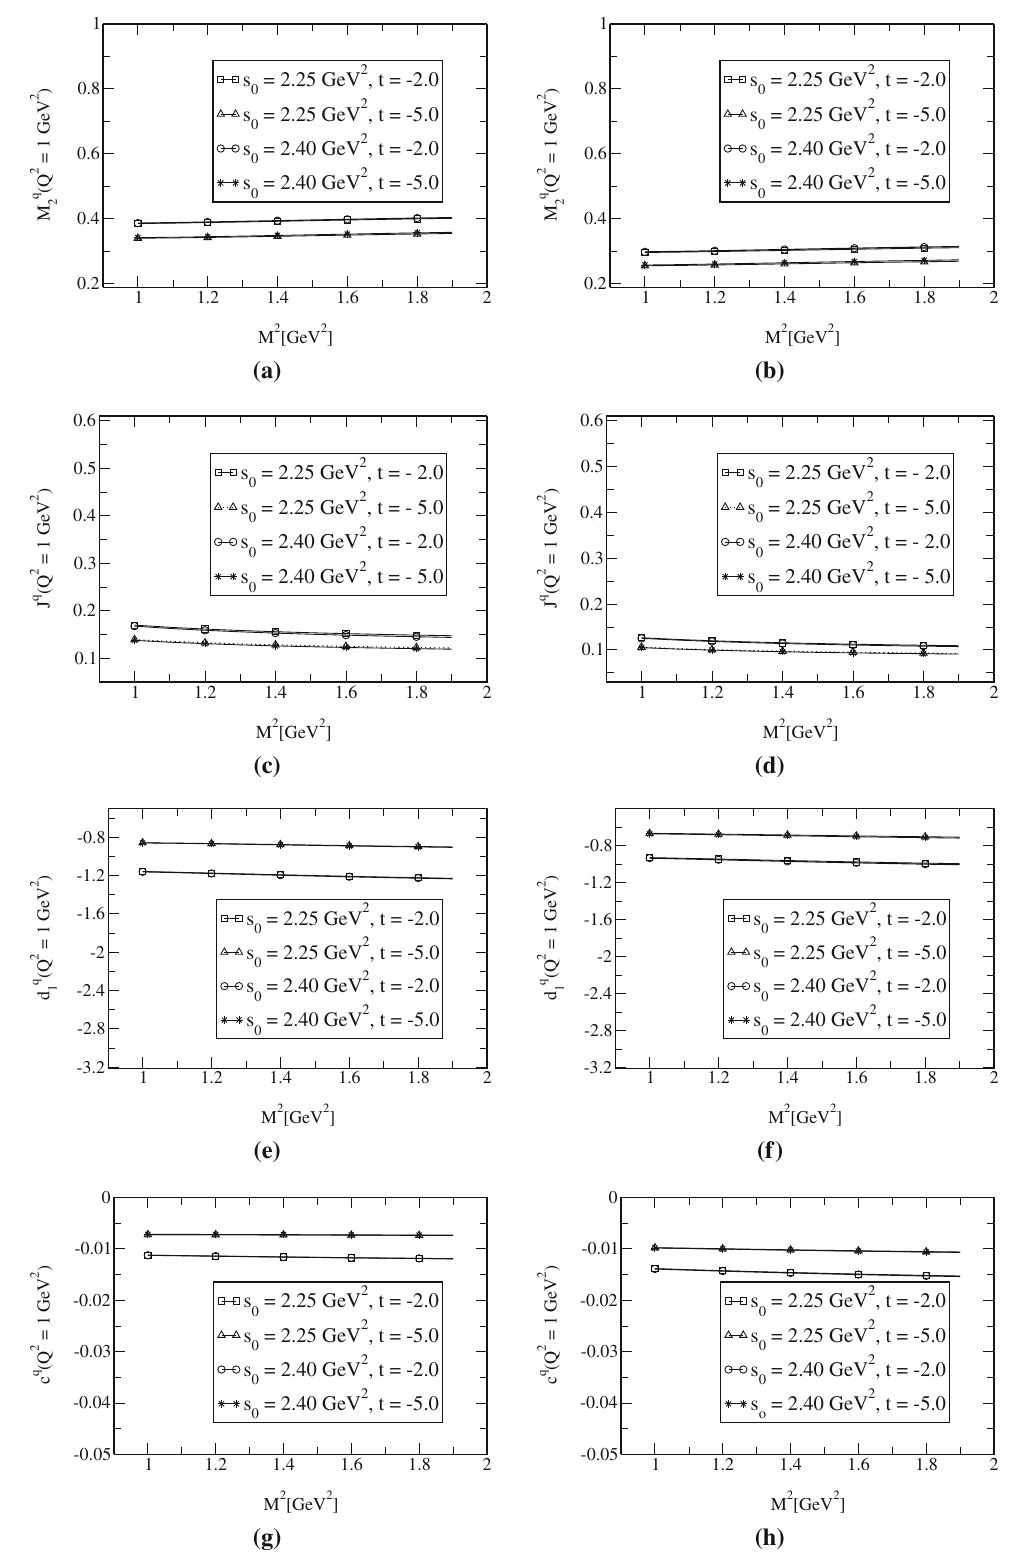
Fig. 1 The dependence of the EMTFFs of nucleon on M 2 at Q 2 = 1 GeV 2 and different values of s 0 and t at their working window: a , c , e and g for the first set of DAs; b , d , f and h for the the second set of